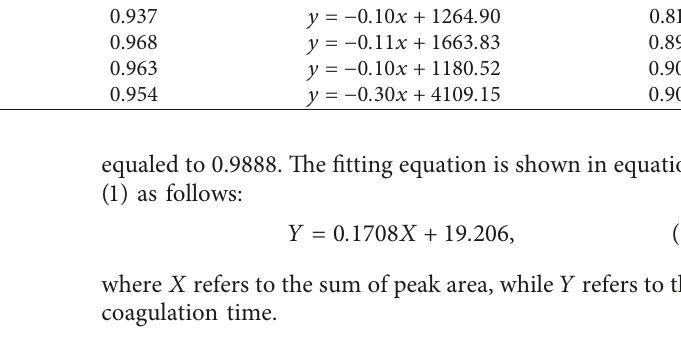
Table 1: The relationships between peak areas and drying time and its correlation coefficient ( R 2 ) of three alkaloids during drying process. Alkaloids